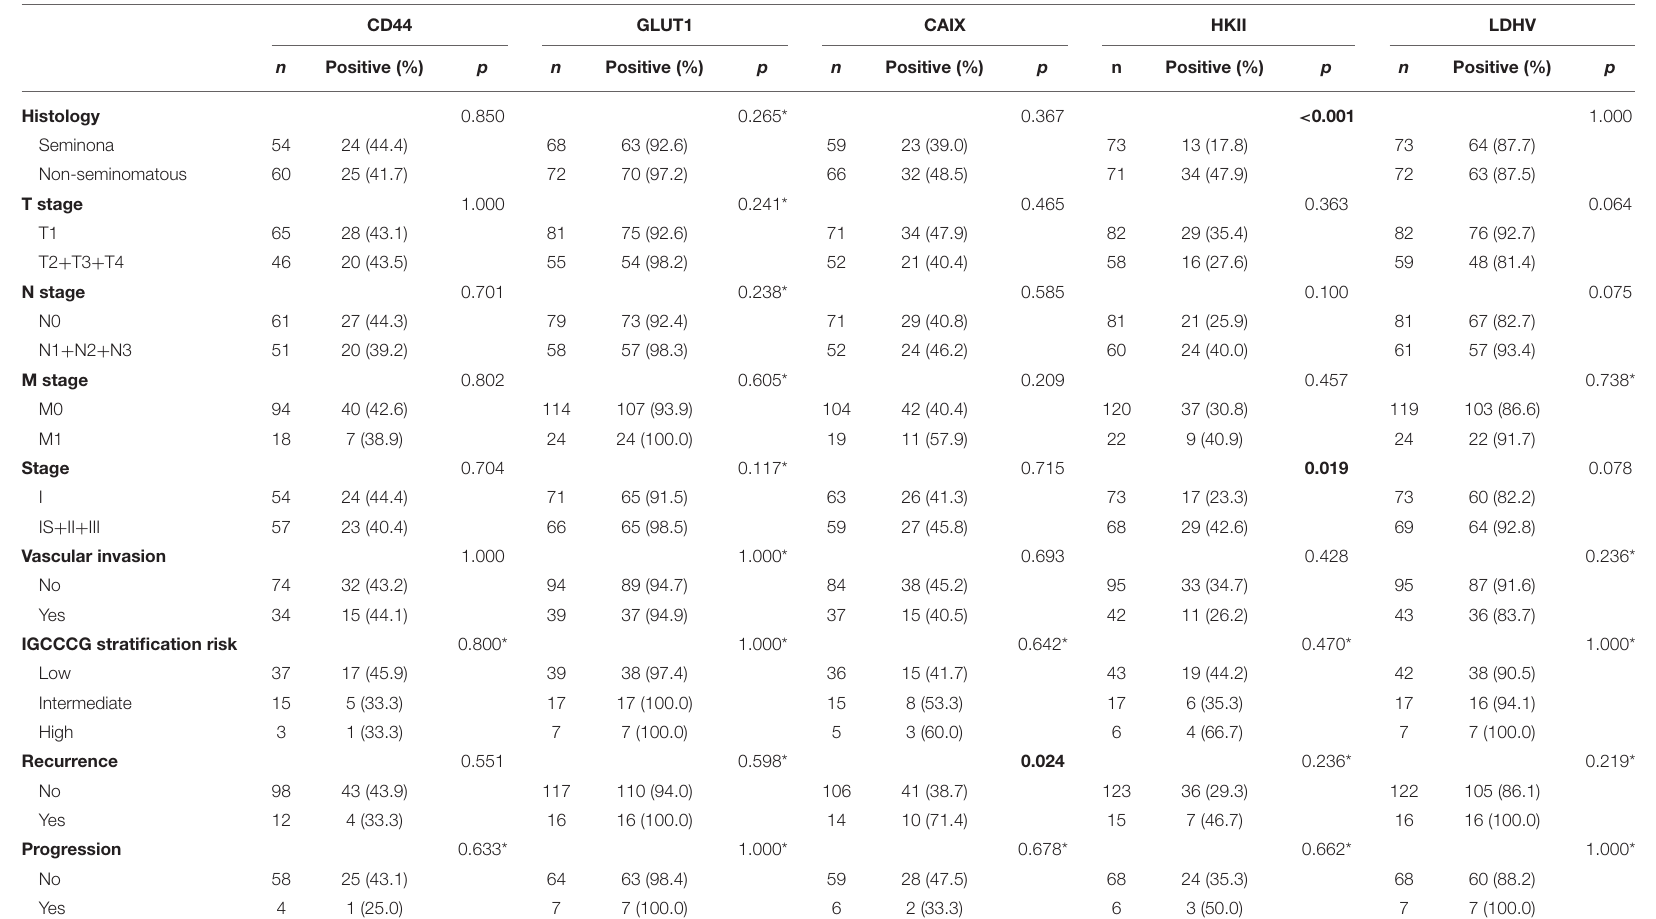
TABLE 3 | Association of CD44, GLUT1 and CAIX membrane expression and cytoplasmic expression of HKII and LDHV with clinicopathological characteristics of adult testicular germ cell tumors. CD44 GLUT1 CAIX HKII